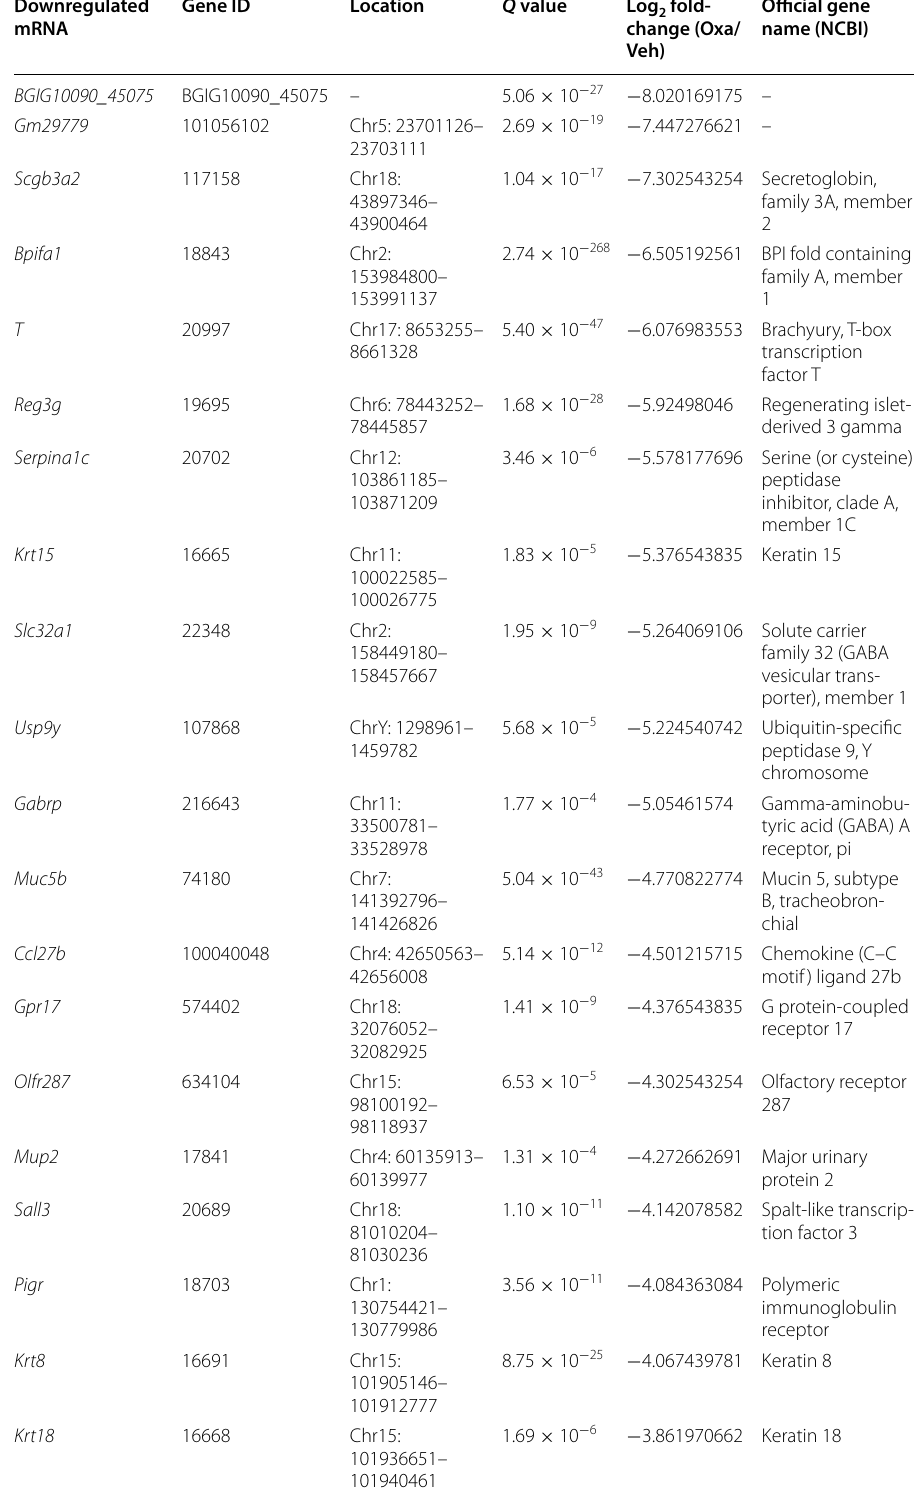
Table 3 Detailed information on the top 20 downregulated DEmRNAs Downregulated